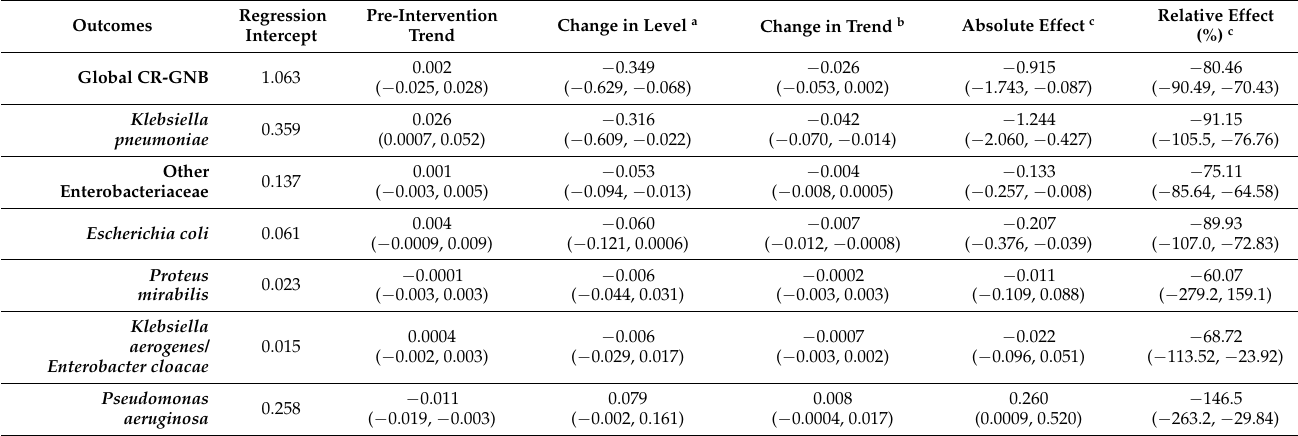
Table 2. Interrupted time-series analysis of changes in trends of incidence density of carbapenem-resistant Gram- negative